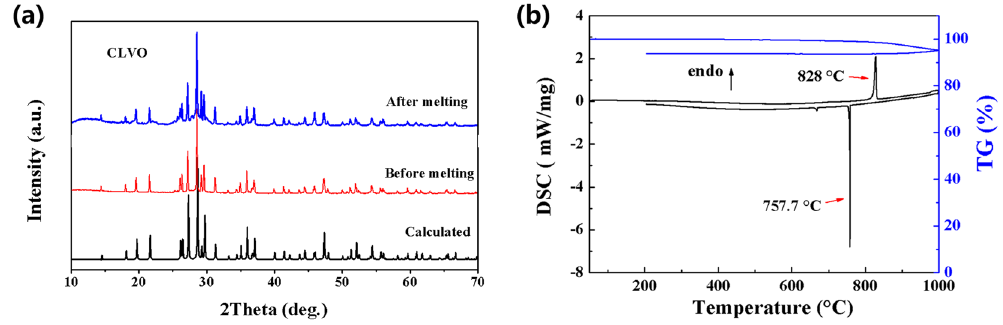
Figure 1. ( a ) Calculated and experimental PXRD for CLVO. ( b ) The TGA-DSC data for